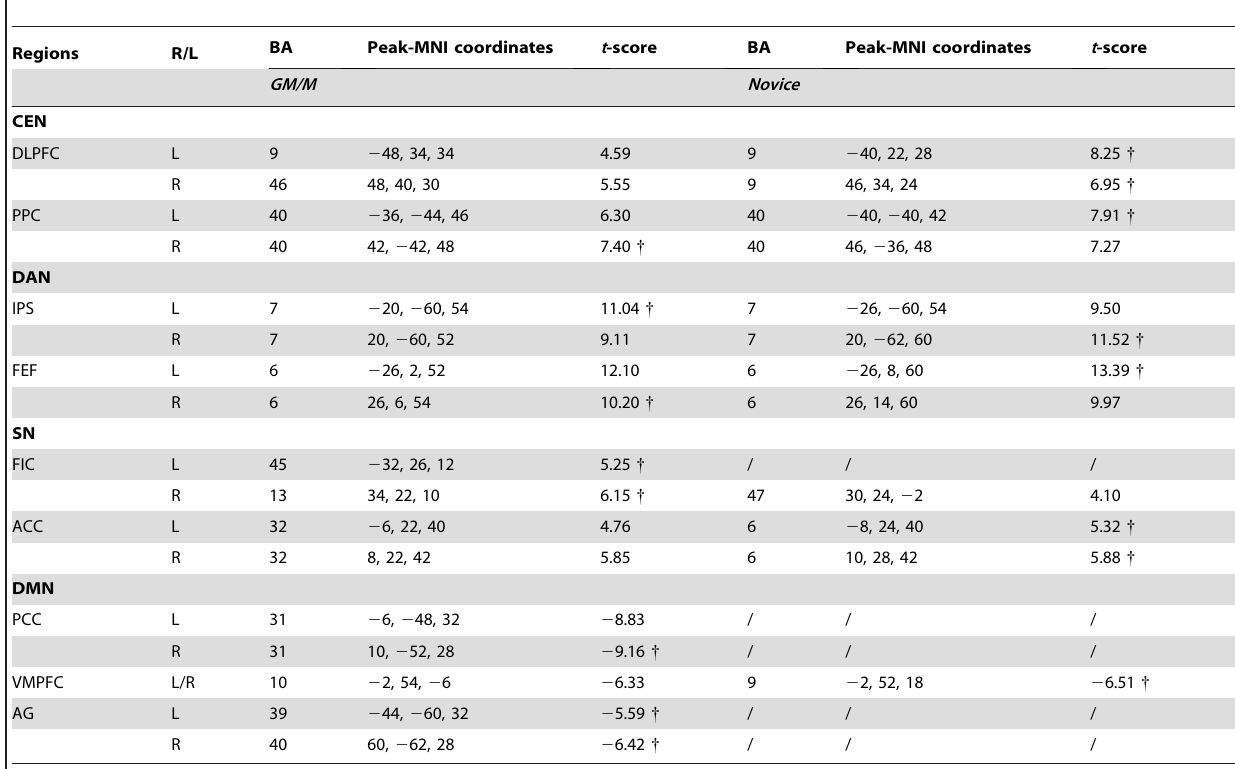
Table 1. Coordinates of CEN, DAN, SN activation and DMN deactivation during Chinese chess problem-solving task (Game condition vs. Blank board condition) ( p , 0.05, AlphaSim corrected).